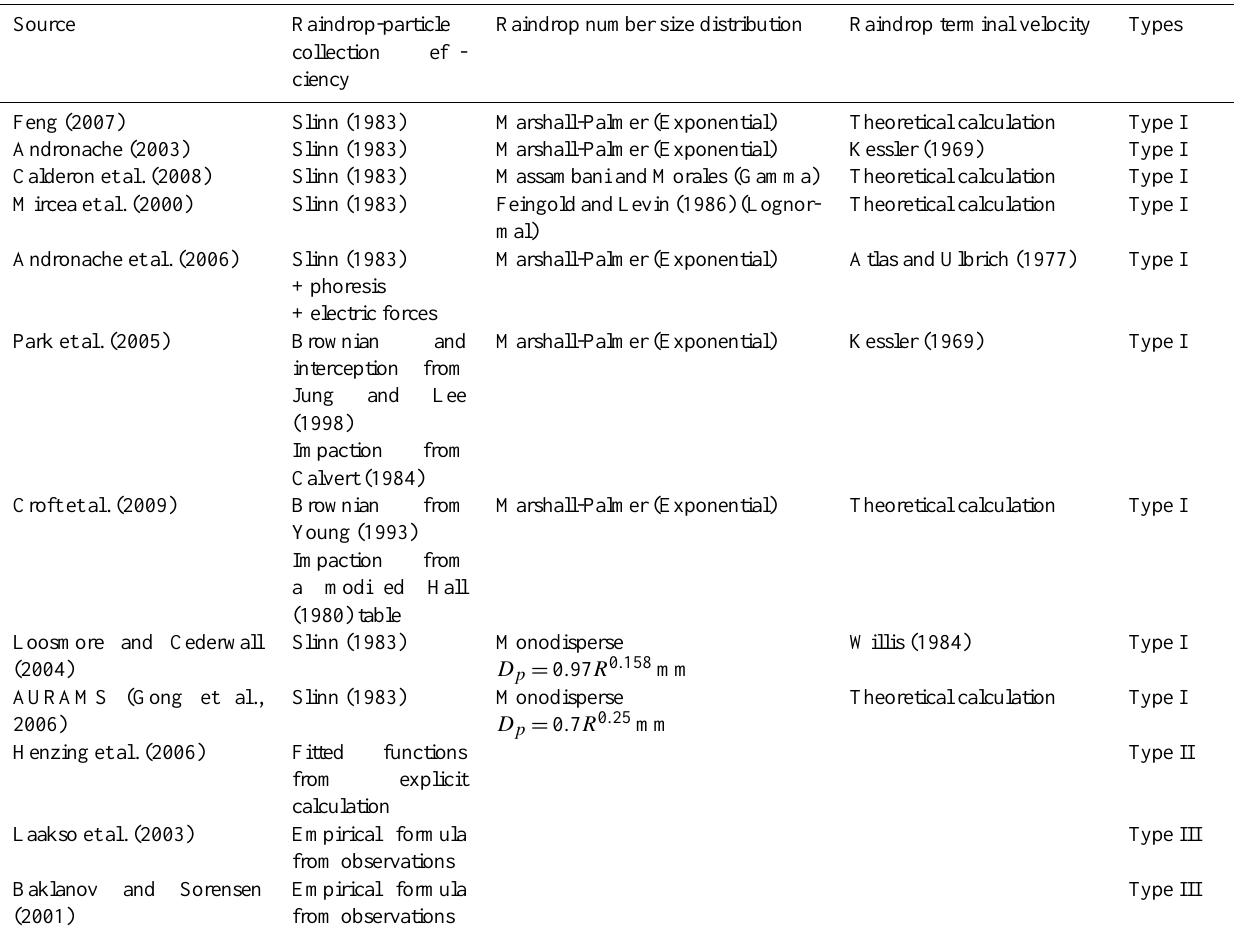
Table 3. Current size-resolved 3 parameterizations for below-cloud particle scavenging by rain. Type I denotes a theoretical